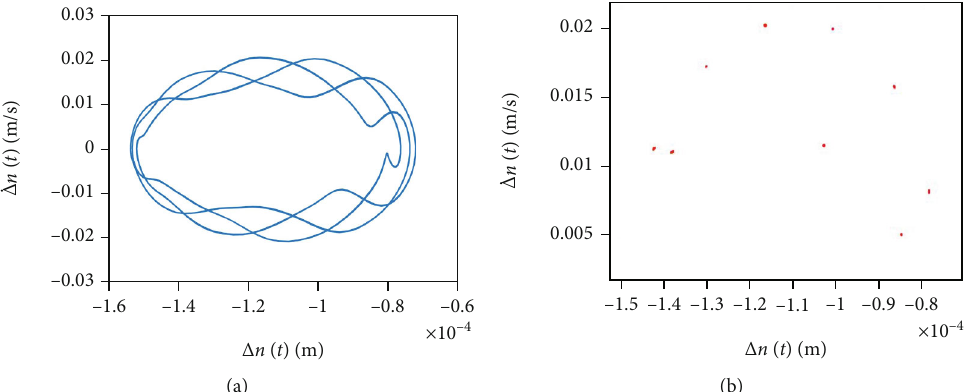
Figure 12: When the misalignment in the x direction is 3 : 05 × 10 − 4 m: (a) relative displacement velocity and (b) the corresponding diagram of